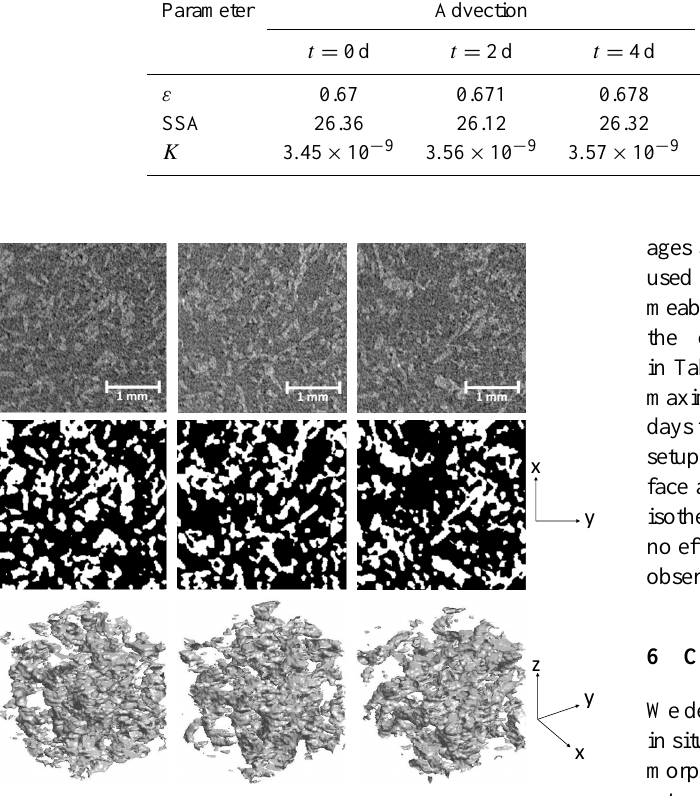
Figure 6. Raw reconstructed µ -CT signal of one scan and the cor- responding segmented images and 3-D renderings at (left) t = 0, (middle) t = 2days, and (right) t = 4days. The dimensions of the displayed images are 3mm 2 , and the 3-D renderings are 1.5mm 3 . The images were taken perpendicular to the flow direction ( z axis). The bright phase corresponds to ice and the dark phase corresponds to